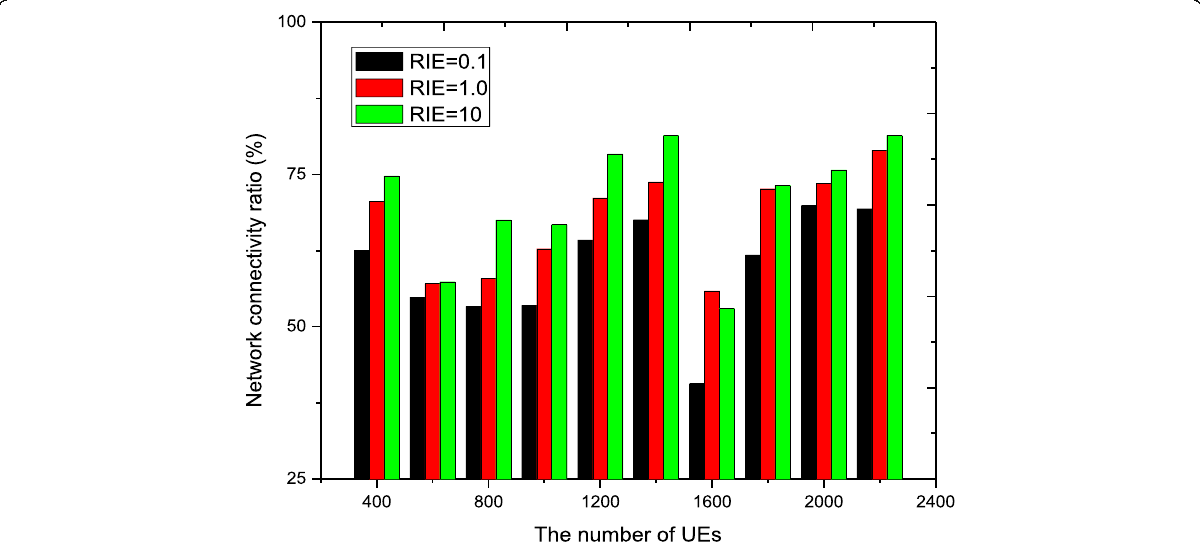
Fig. 15 Network connectivity ratio for the DTO-MROD scheme under the different typical values for RIE